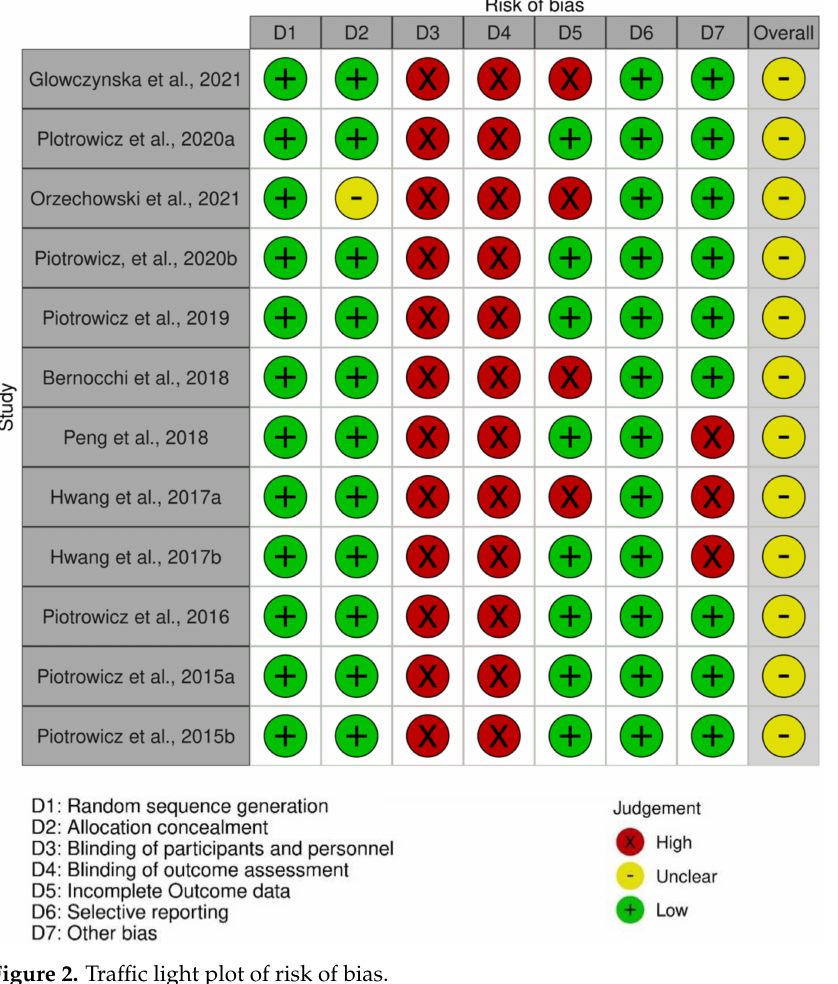
Figure 2. Traffic light plot of risk of bias.